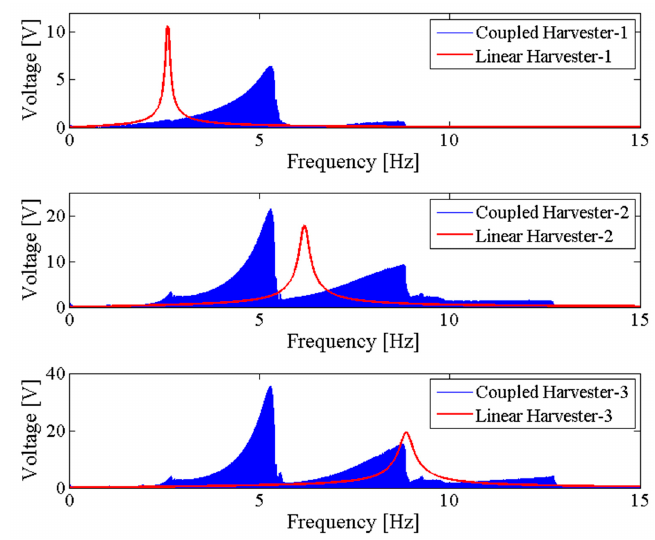
Figure 10. Output voltage of the NPEHS-2.